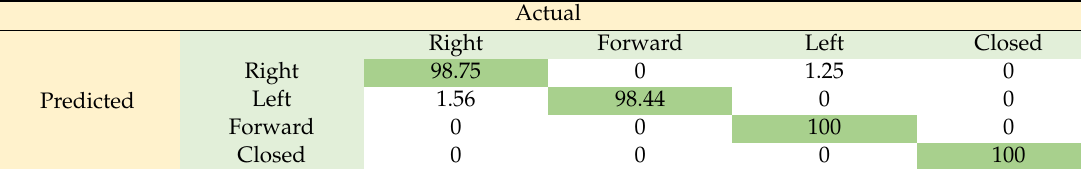
Table 3. Summary of the implemented system’s evaluation metrics.